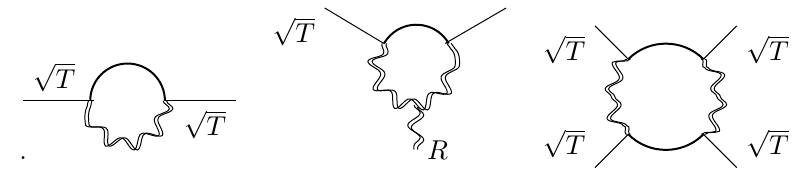
Figure 4 . Non-exhaustive set of diagrams for mixed